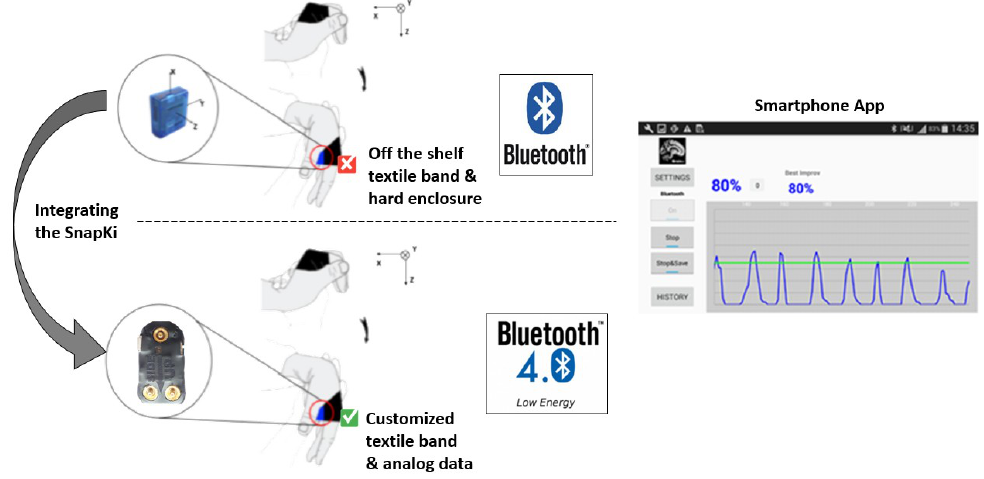
Figure 11. iHandU system architecture before and after the application of the SnapKi system. Differences: hardware inertial unit, textile band and data transference protocol (Bluetooth to BLE).